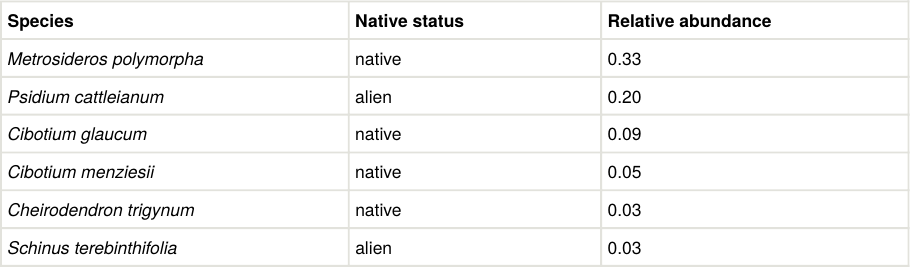
Relative abundance (proportion of individuals) of the 25 most abundant tree, shrub and tree fern species across the Hawaiian archipelago in